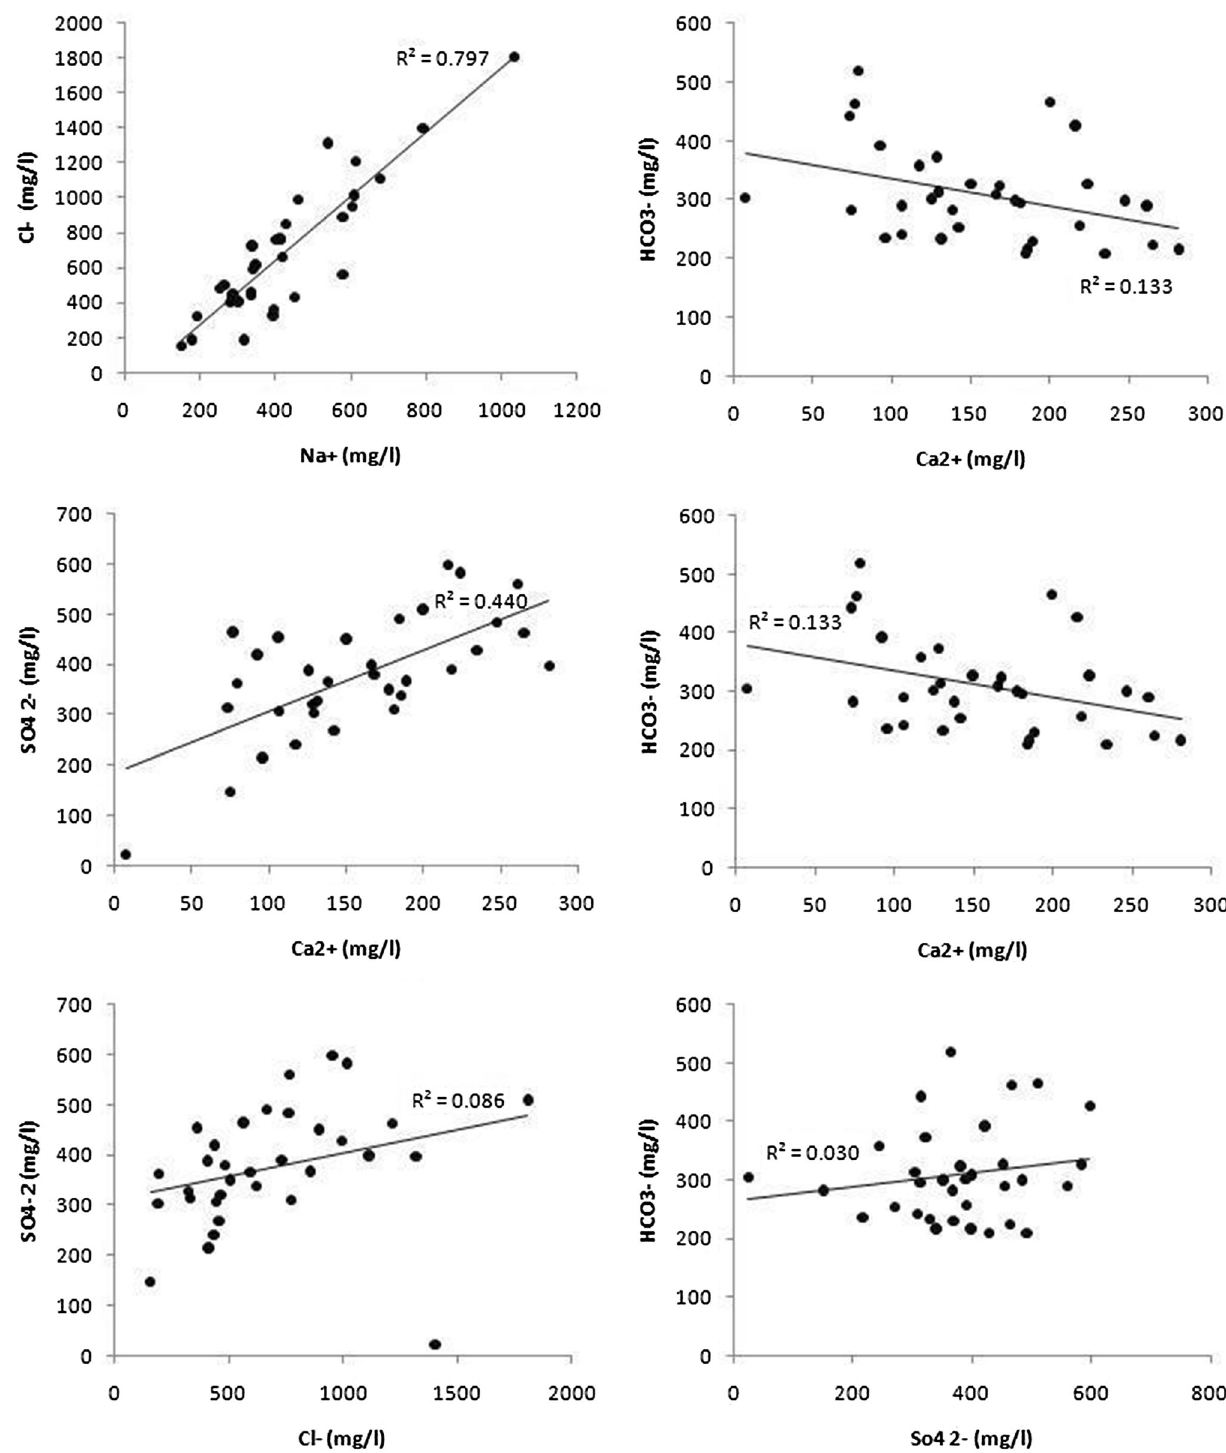
Fig. 8 Concentration of various major ions. The linear correlation between them is shown by R